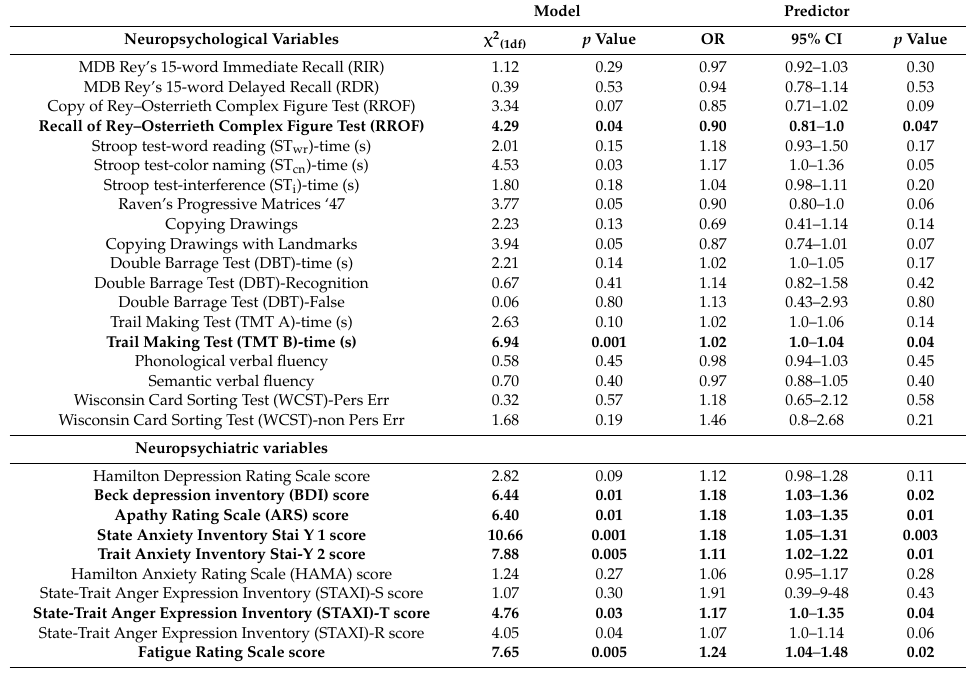
Table 2. Results from the separate binomial logistic regressions on group membership (WMH + WMH − ) and each neuropsychological and neuropsychiatric measure.